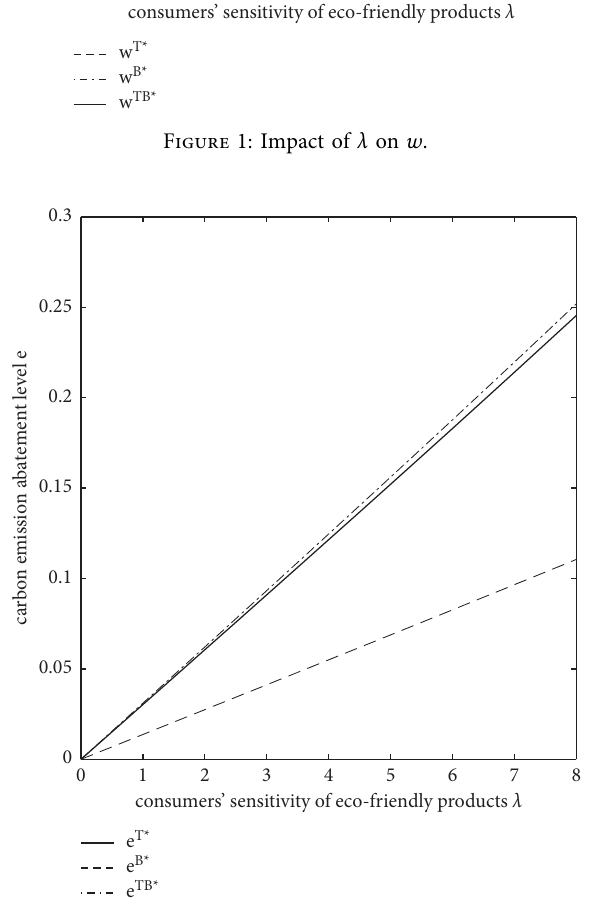
Figure 2: Impact of λ on e .